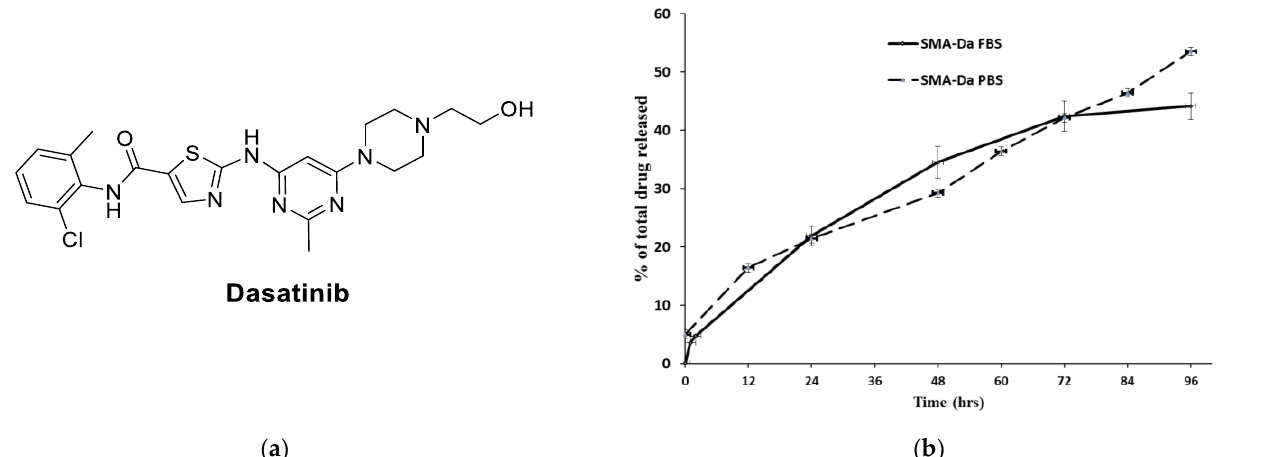
Figure 1. ( a ) Chemical structure of dasatinib; ( b ) SMA–dasatinib drug release studies. Cumulative release of the free drug from SMA–dasatinib micelles at pH 7.4 in PBS and FBS.